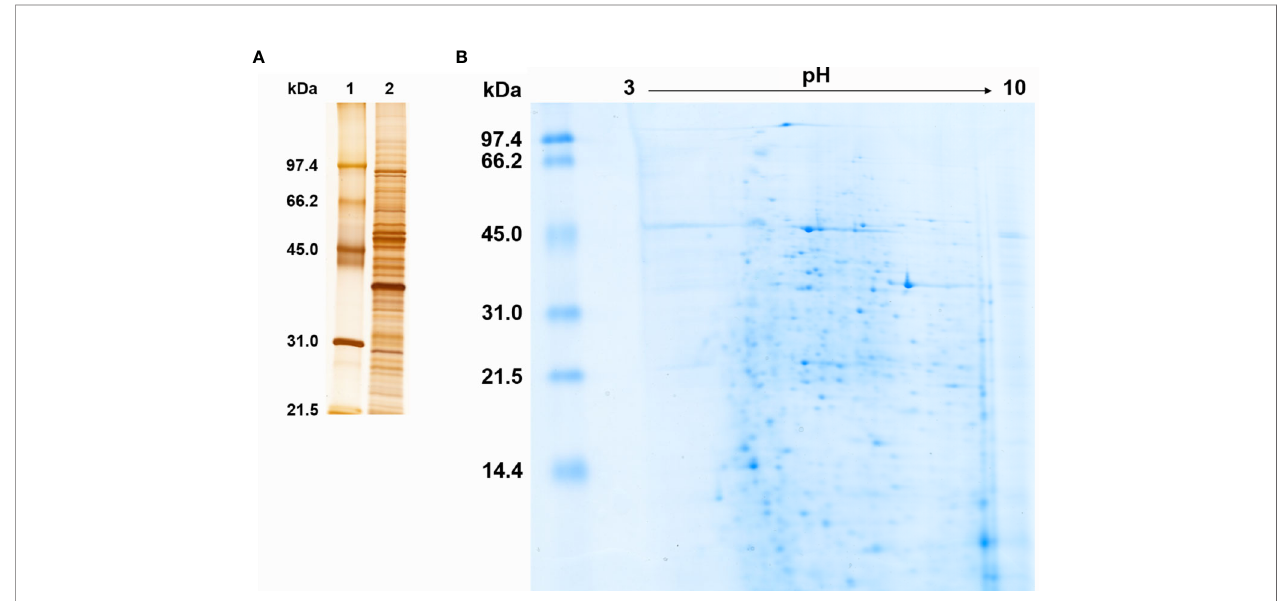
FIGURE 1 | Protein pro fi le of Histoplasma capsulatum yeast cell extract. (A) Silver stained SDS-PAGE under reducing conditions. 1, Molecular mass standard; 2, Yeast cell extract of H. capsulatum . Numbers on the left correspond to the molecular mass (kDa) of the standards. (B) Colloidal Coomassie blue stained 2DE. The linear pH gradient range is indicated above the gel and the molecular mass standards (kDa) are on the